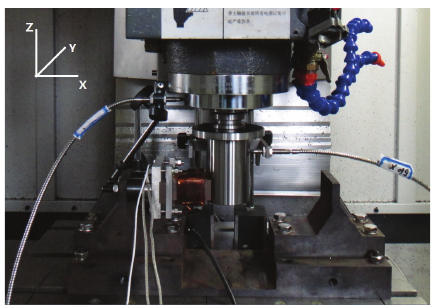
Figure 1: Electromagnetic loading experiment